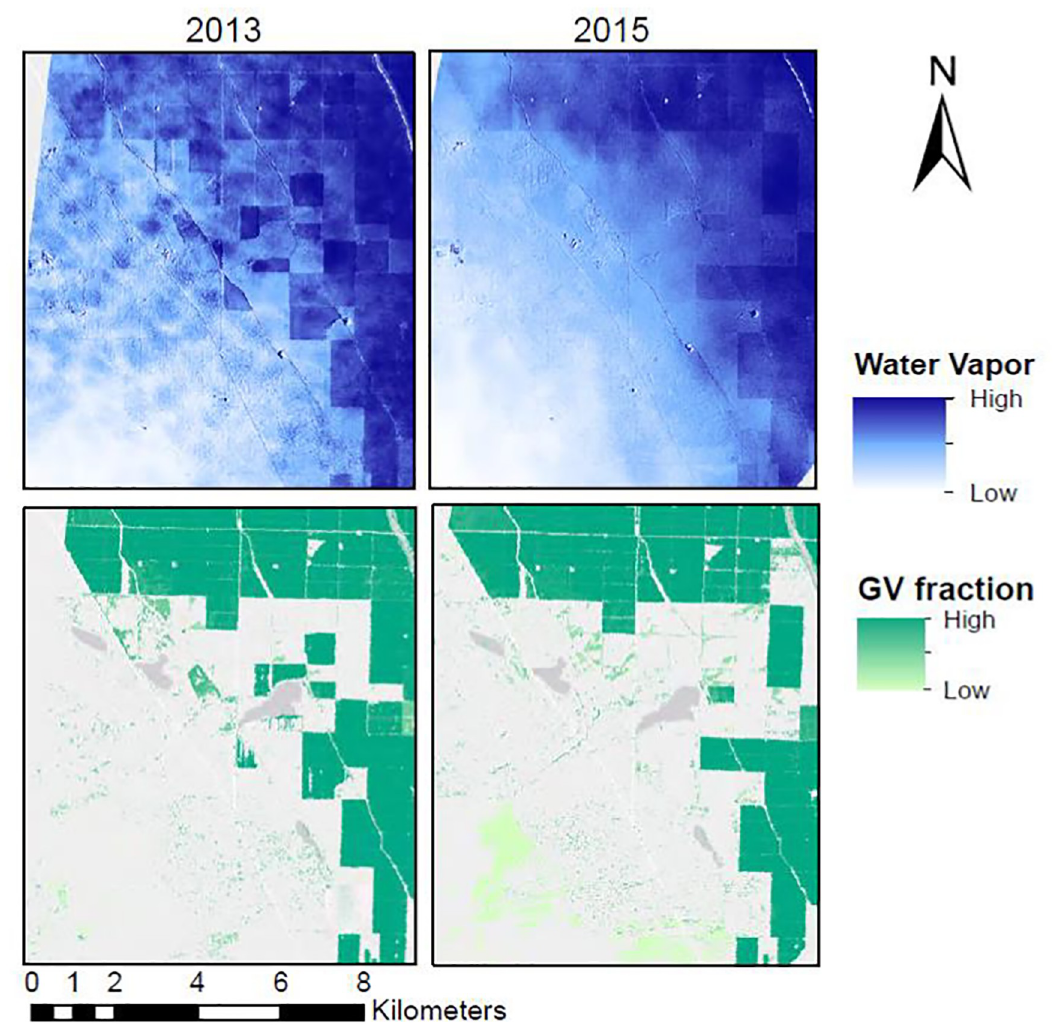
Fig 10. Subset of the water vapor and GV fraction in the southern study area. Water vapor imagery and GV fraction results from 2013, and 2015 illustrate how water vapor occurs over both cropped and fallow areas in part of the study area (35.463˚, -119.696˚). 2013 and 2015 images show greater concentrations of water vapor over cropped than non-cropped areas. The location of the subset is shown on Fig 6 marked with an A. Basemap obtained from Esri ArcGIS. Sources: Esri, DeLorme, HERE,